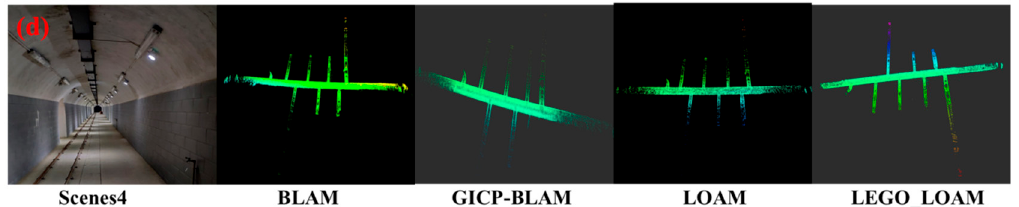
Figure 11. ( a ) Shows the indoor scene of an office that has not been renovated and the point cloud map constructed using the four SLAM methods; ( b ) the office corridor scene and the point cloud map constructed using the four SLAM methods; ( c ) shows the “ring” type underground roadway scene and the point cloud map constructed by using four SLAM methods; ( d ) is the underground main roadway scene and the point cloud map constructed by using four SLAM methods.